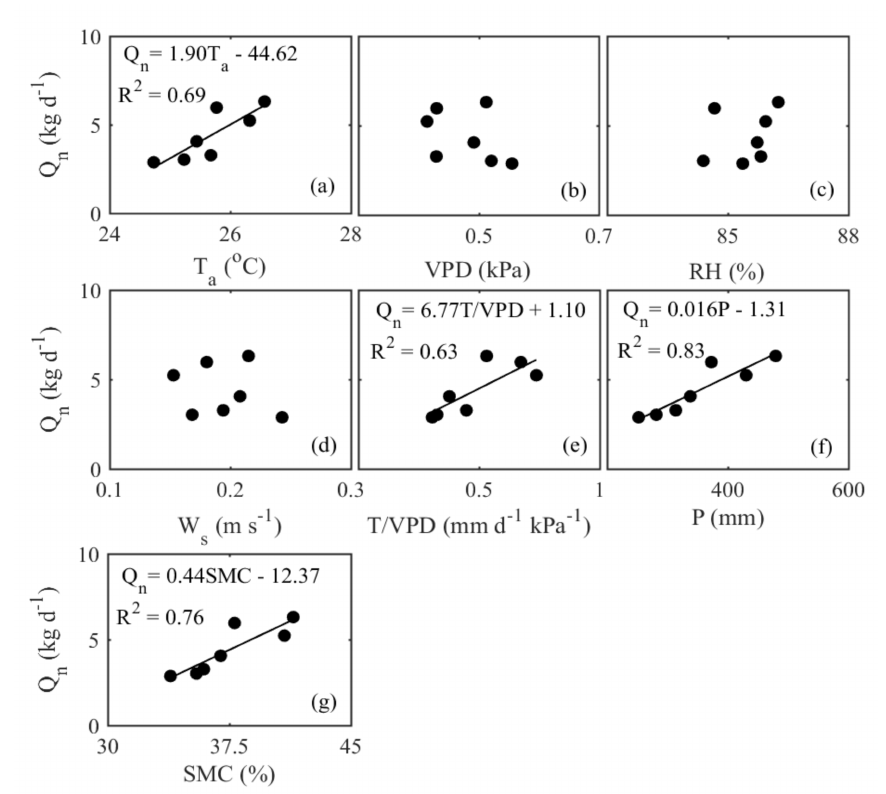
Figure 7. Interannual response of growing season nighttime mean sap flow (Q n ) to site micro- hydrometeorological parameters, i.e., ( a ) air temperature (T a ), ( b ) vapor pressure deficit (VPD), ( c ) relative humidity (RH), ( d ) wind speed (W s ), ( e ) canopy conductance (T/VPD), ( f ) soil moisture content (SMC), and ( g ) total nighttime precipitation (P) over 2014–2020. Data points indicate growing season annual nighttime means for all parameters but annual total for P.